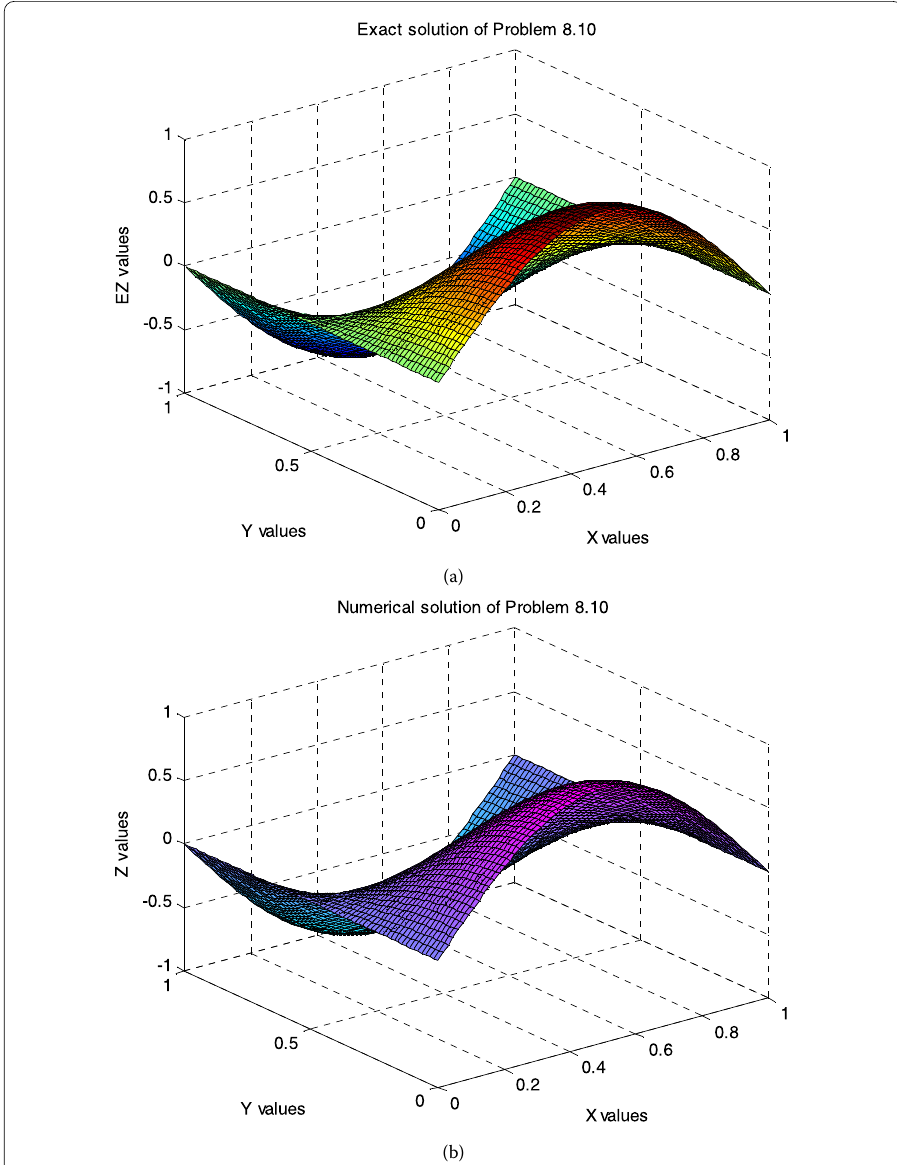
Figure 11 ( a ) Exact solution of Problem 8.10 for h = 1/64 and α = 10. ( b ) Numerical solution of Problem 8.10 for h = 1/64 and α = 10